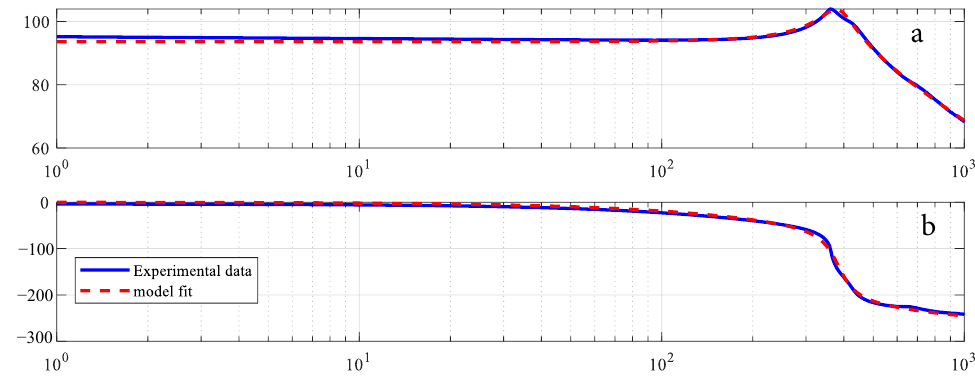
Figure 12. Frequency response ( a ) Magnitude ( b ) Phase.